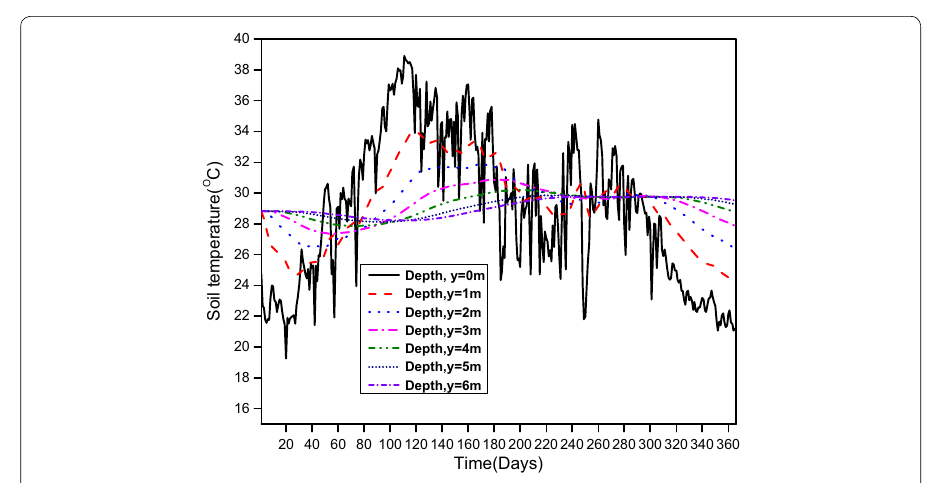
Fig. 10 Annual variation of soil temperature with